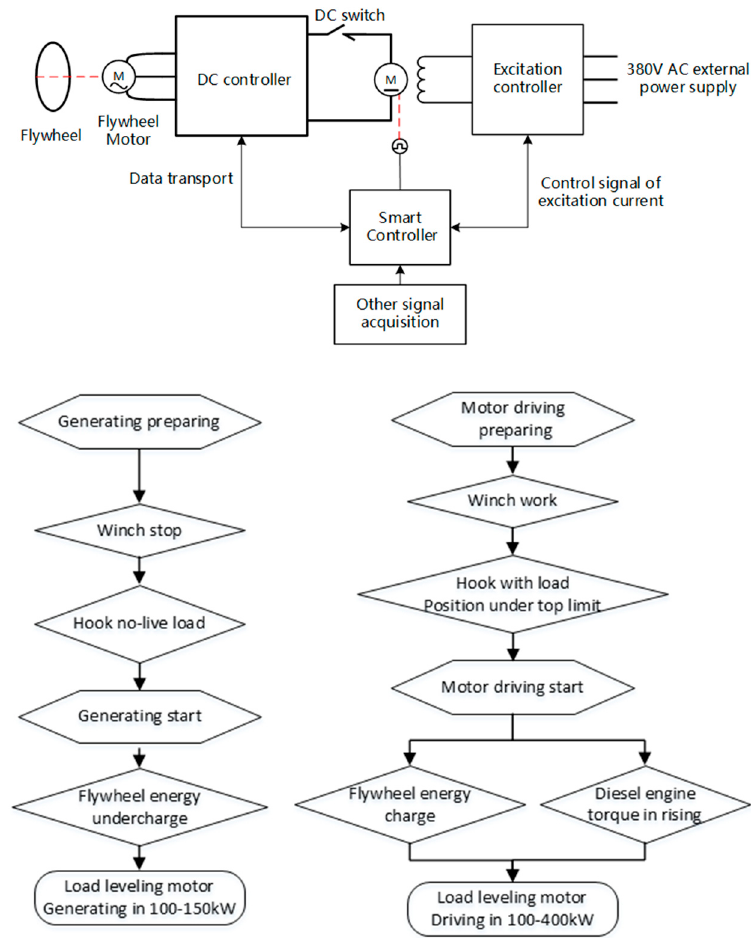
Figure 14. The peak load leveling control system and control flow.